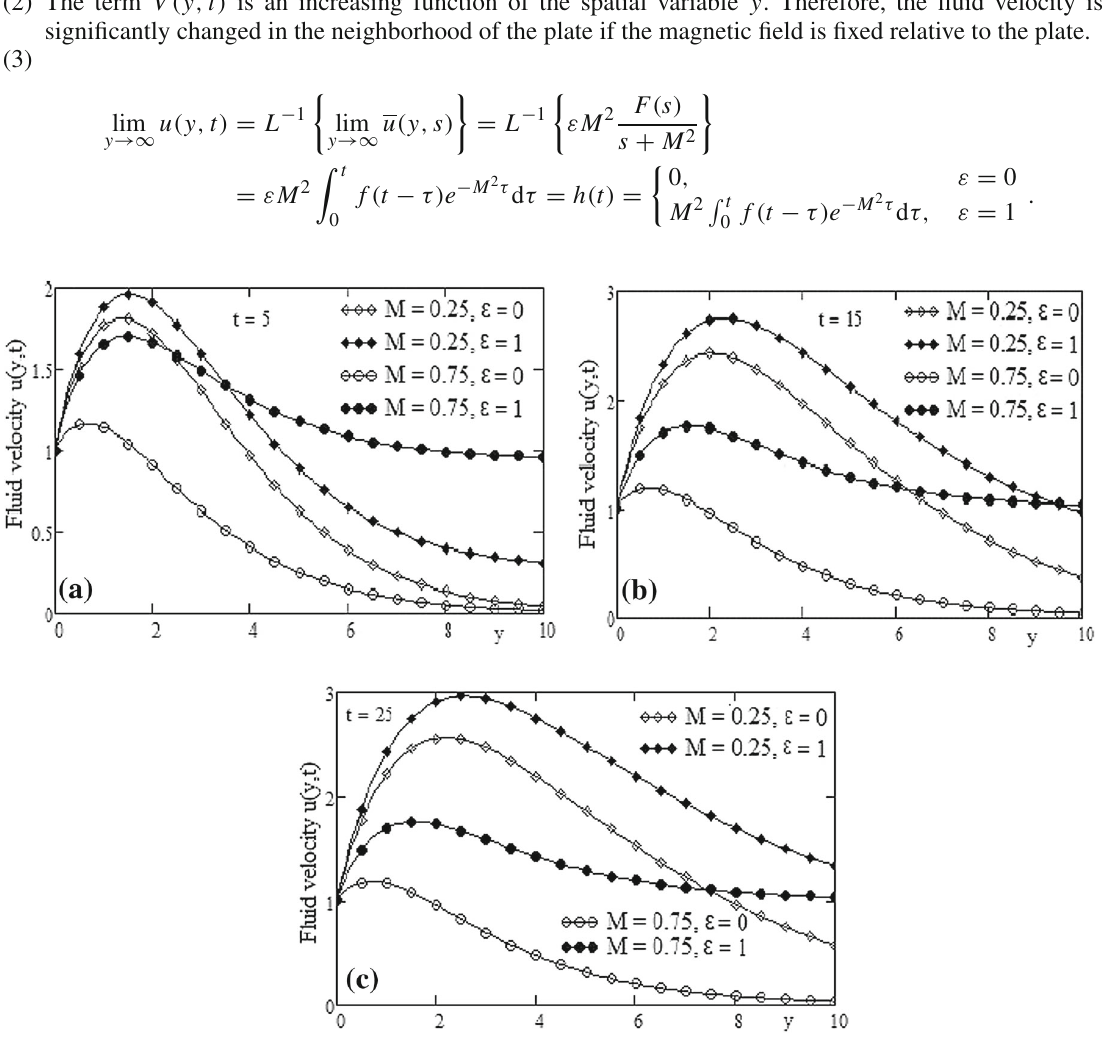
Fig. 1 Profiles of the dimensionless velocity given by Eq. (25) for Pr = 0 . 71, Q = 0 . 6, Sc = 0 . 2, R = 0 . 7, Gr = 1 . 25, Gm = 0 . 5, M = 0 . 25, and 0 . 75 and different values of time